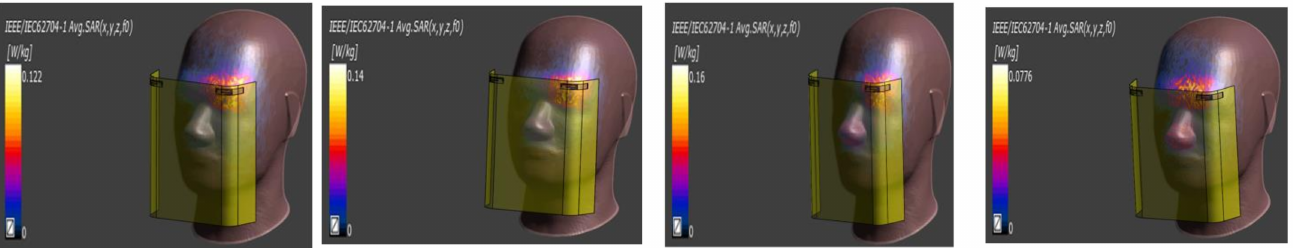
Figure 39. 10 g SAR Simulation Results for Ant. 3 at 2.4 GHz, 3.5 GHz, 5.5 GHz, and 6.8